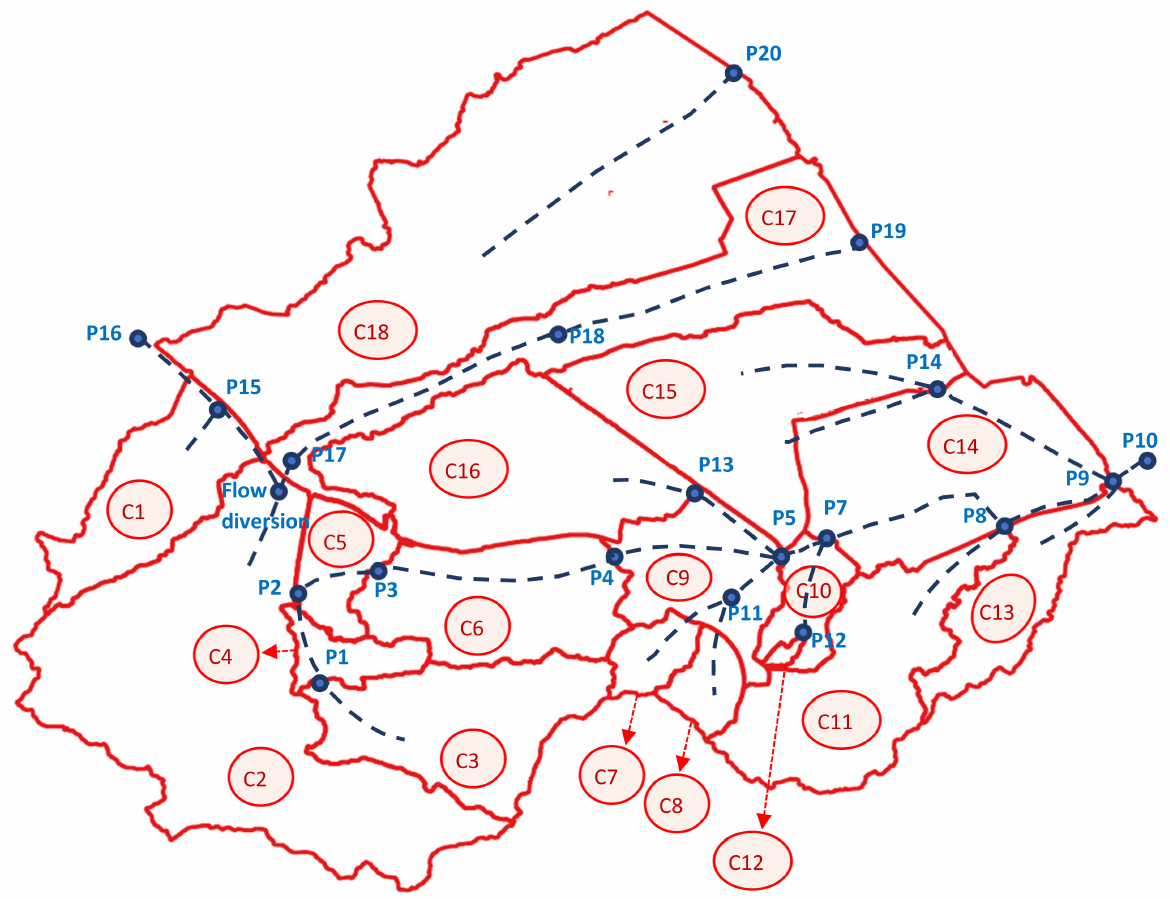
Figure 6. Conceptual operation scheme.